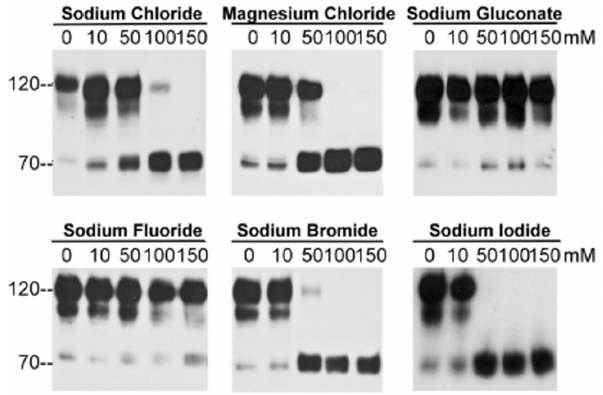
Figure 4. Chloride ions but not sodium ions suppress matriptase zymogen activation. Living 184 A1N4 mammary epithelial cells were exposed to pH 6.0 phosphate buffers containing increasing concentrations of the indicated salts at room temperature for 20 min. Cell lysates were prepared and assayed by immunoblot analyses for matriptase using mAb